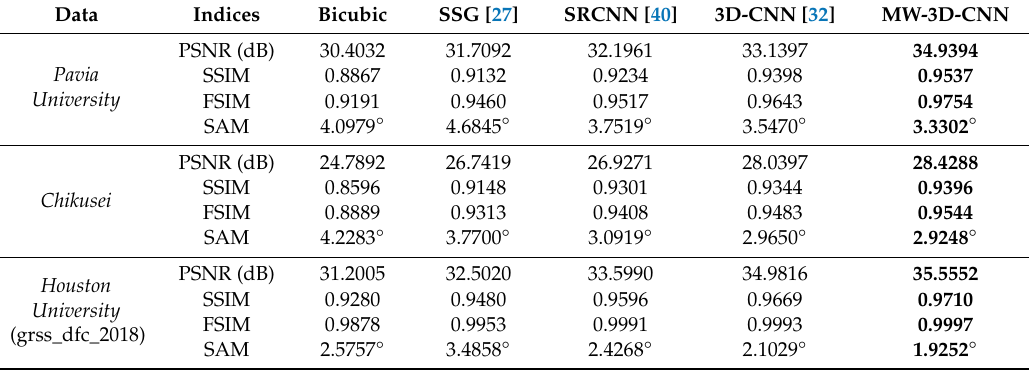
Table 1. The assessment indices of different HSI SR methods by an upscaling factor of two. Data Indices Bicubic SSG [27]